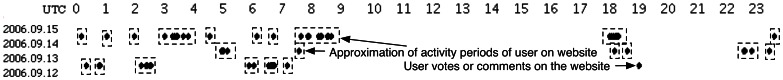
The record of a user's votes on the Digg.com website, each indicated by a dot on the timeline, provides a lower bound estimation of the user's presence on the website, as well as an upper bound on this user's observation times, exemplary for four consecutive days in Sep. 2006.